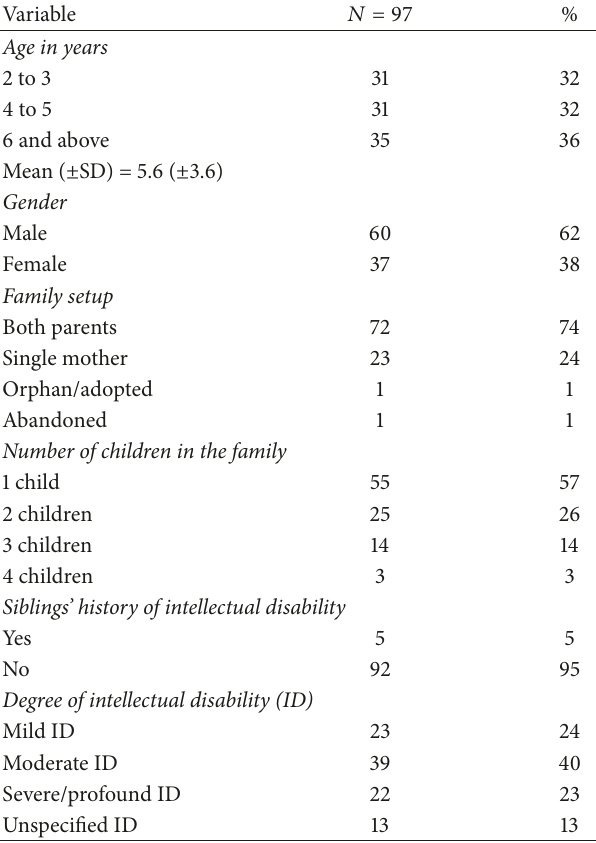
Table 2: Selected sociodemographic and economic characteristics of